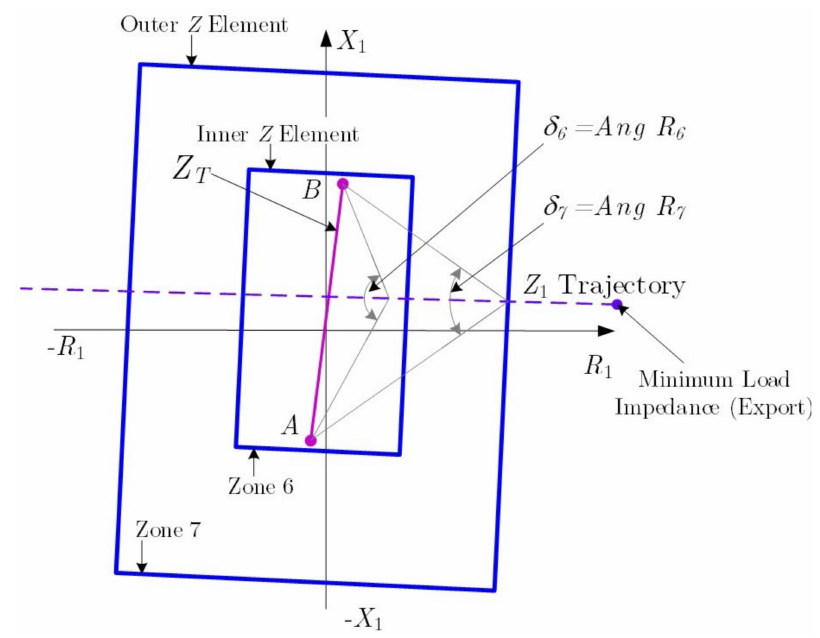
Figure 10. Swing Trajectory to Determine the OOS blocking delay